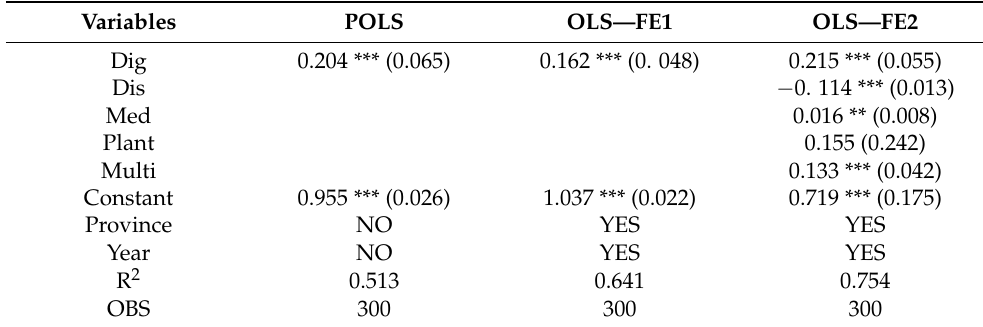
Table 4. Benchmark regression